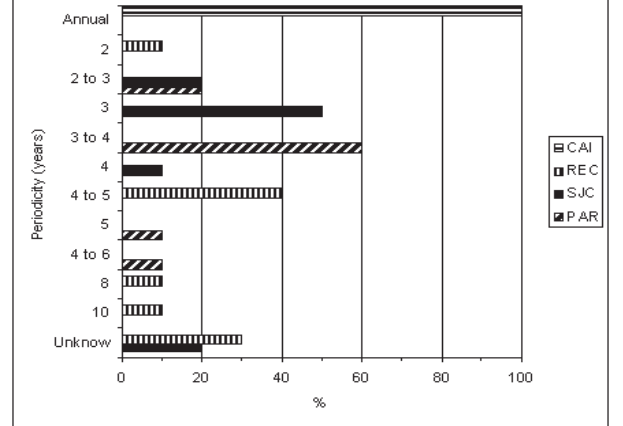
Fig. 17 . Periodicity of the “correção” in Caiçara do Norte (CAI), Recife (REC), São José da Coroa Grande (SJC) and Paripueira (PAR) according to the